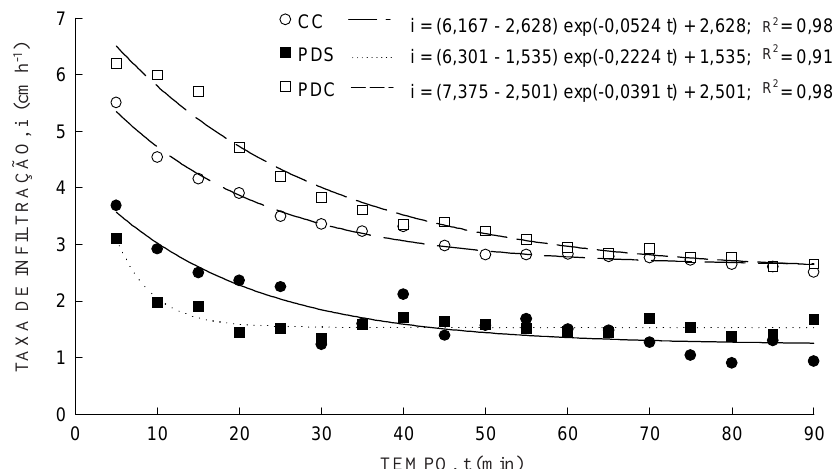
- i ) exp(- aaaaa t) + o c